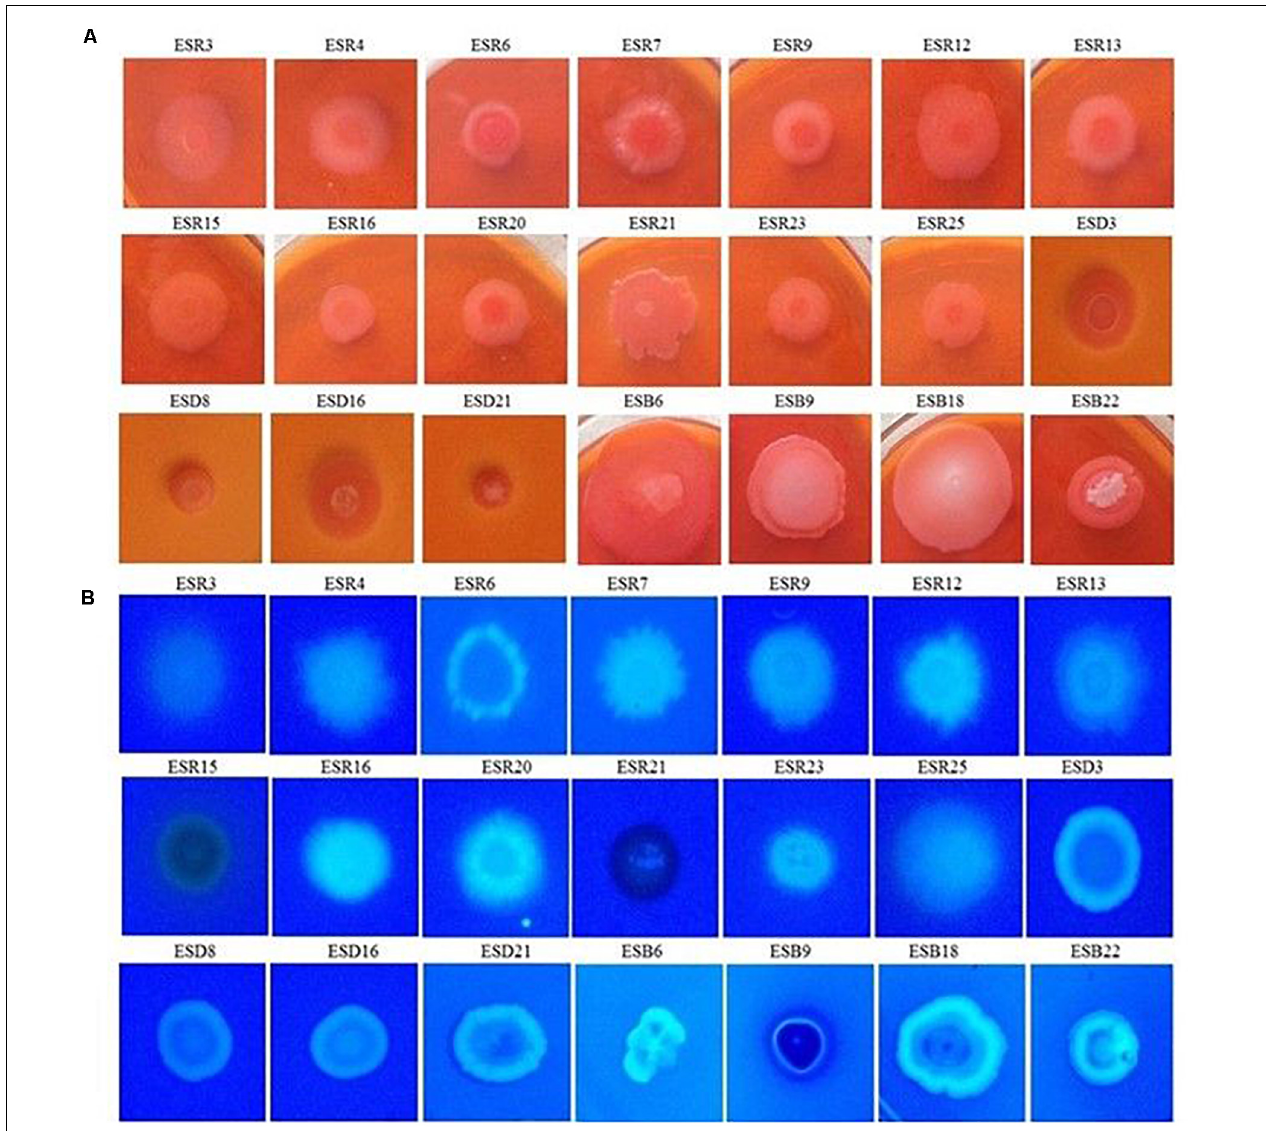
FIGURE 4 | Binding assays. Different rhizobacterial strains were spotted onto Congo red (40 µ g mL − 1 ) (A) , and Calcofluor (200 µ g mL − 1 ) (B) agar plates were then incubated at 28 ◦ C in static conditions for 48 h. Photographs represent one of three experiments, which gave similar